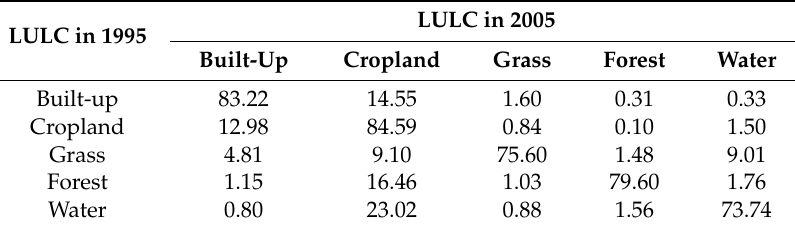
Table A4. Matrix of transition probability in LULC, 1995–2005